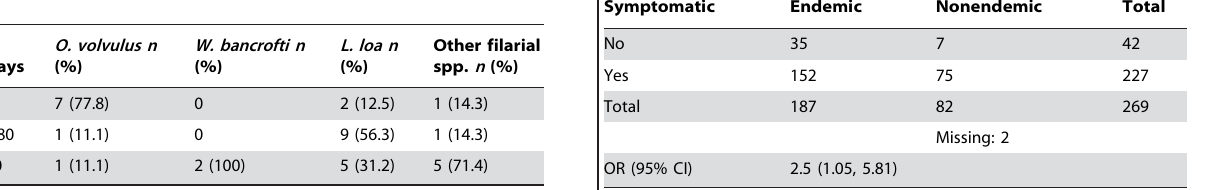
Table 3. Association between patient endemicity status and commonly presenting symptoms of filarial infections Symptomatic Endemic